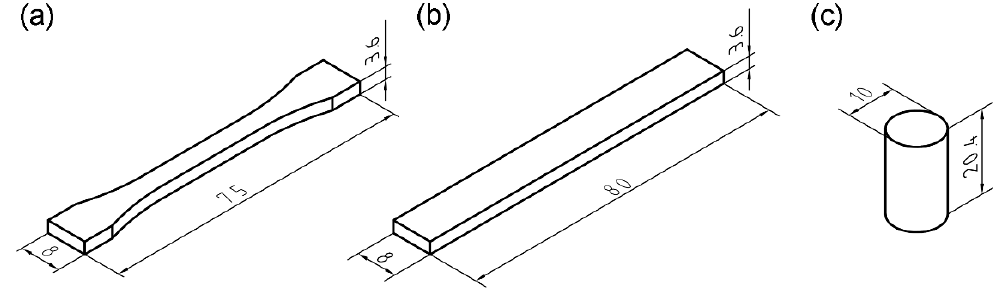
Figure 2. Standard samples for mechanical tests. ( a ) Tensile samples; ( b ) Bending samples; ( c ) Compressive samples.